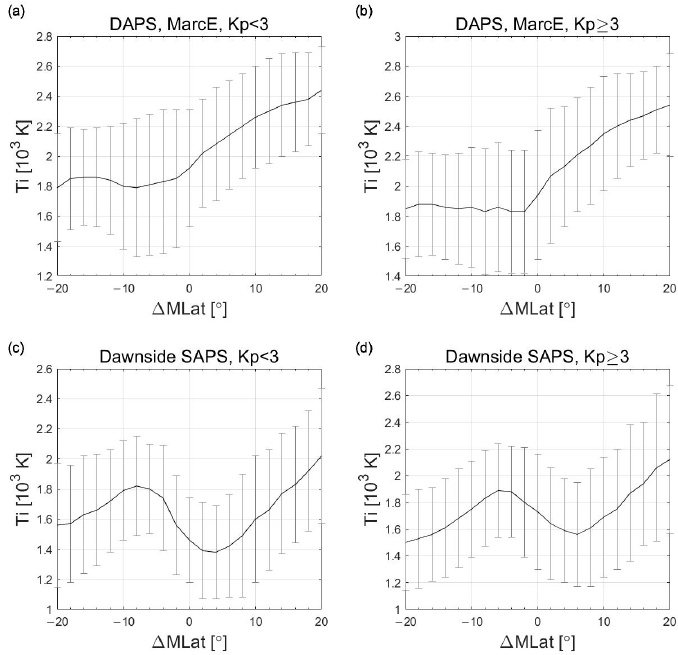
Figure 9. Superposed epoch analyses of the ion temperature for DAPS ( a , b ) at March equinox and dawnside SAPS events ( c , d ) without seasonal separation under different geomagnetic activity levels. The 0 key MLat denotes the latitude where the cross-track velocity peaks. The bars show the mean standard deviations of 2° averages.